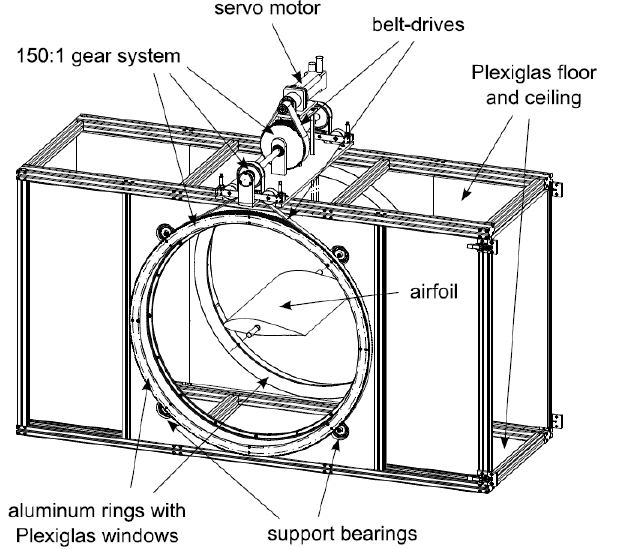
Figure 1. View of the test section showing the pitching mechanism and the approximate location of the airfoil model. From Müller- Vahl